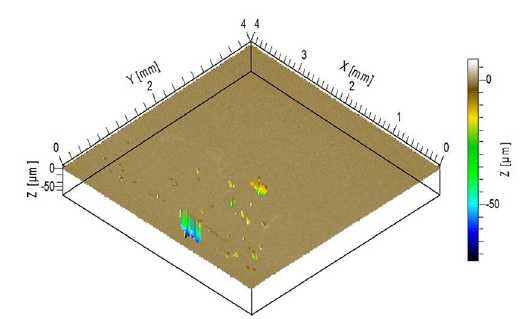
Figure 17. Topography of the 317L steel showing the depth and the distribution of the pits after pressurized